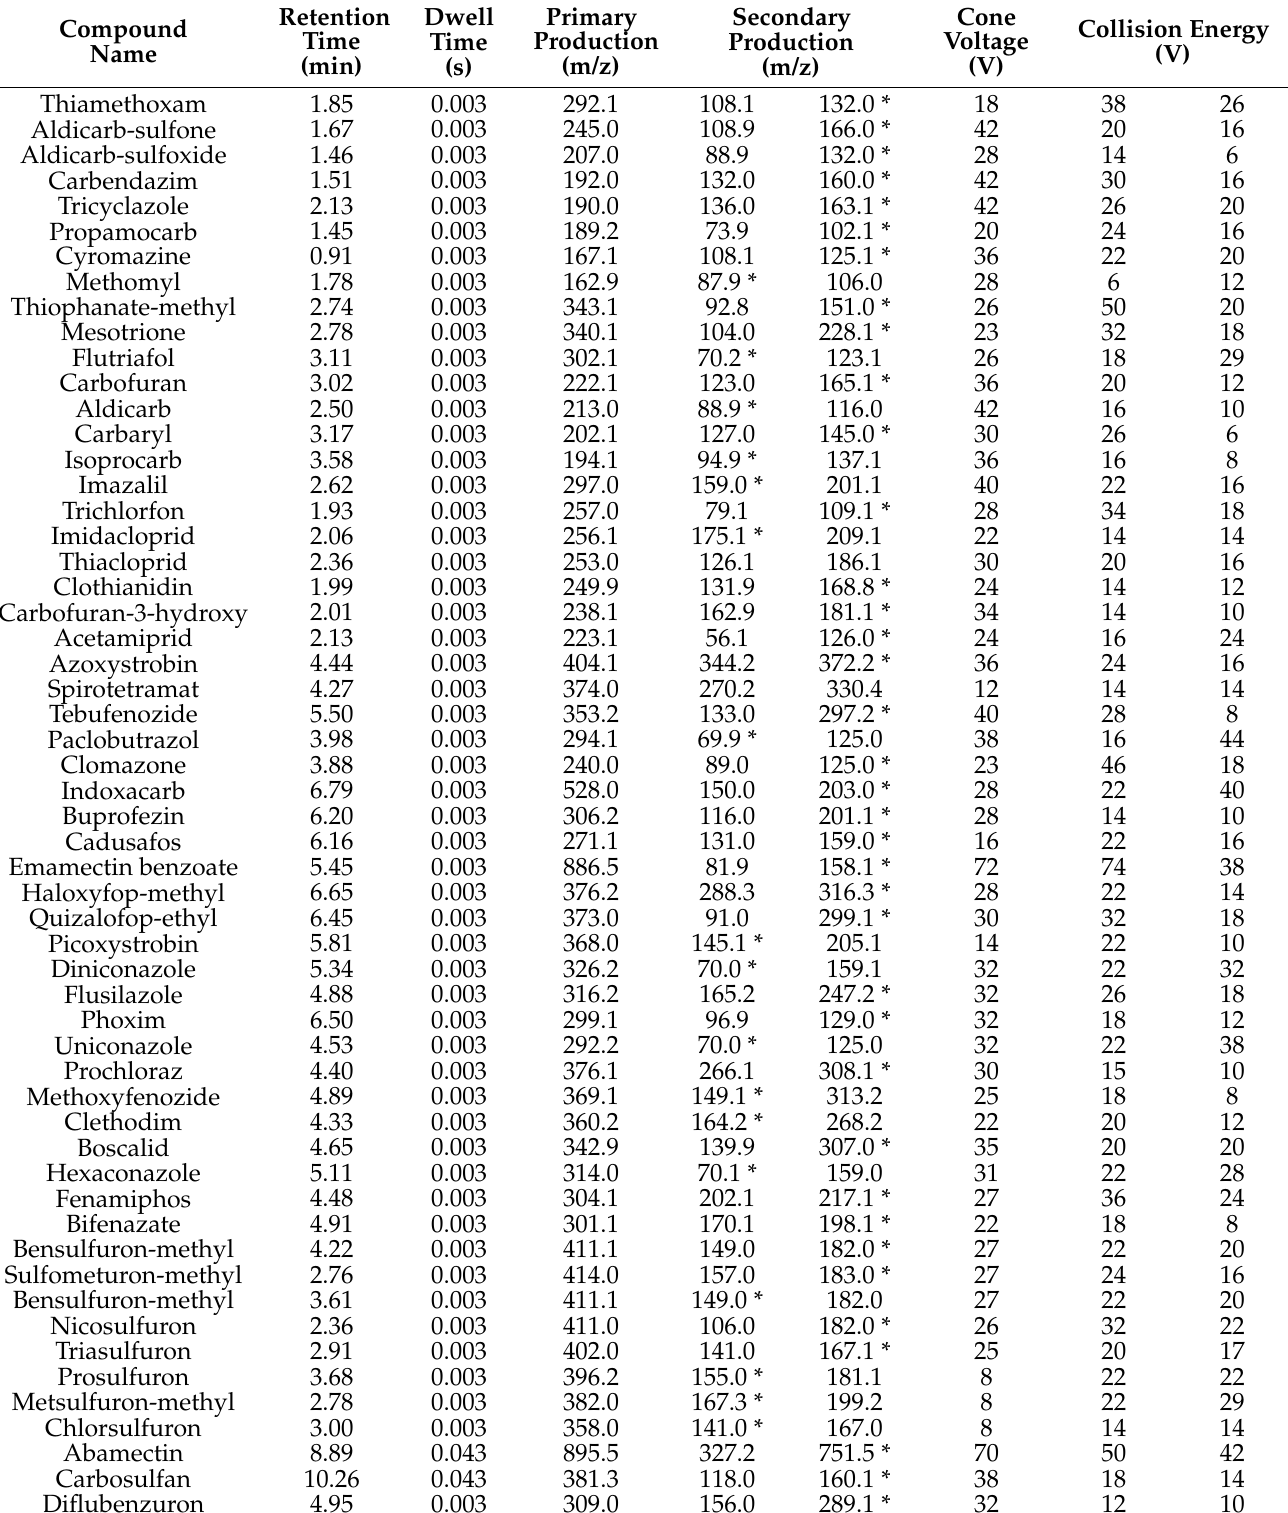
Table A1. UPLC-MS/MS parameters optimized for determination of 56 pesticide